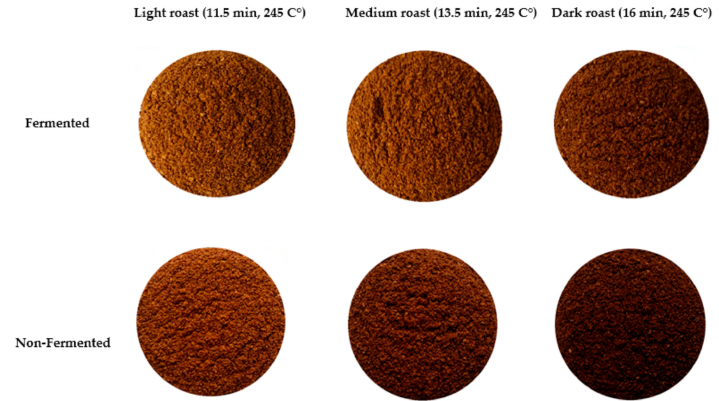
Figure 2. The fermented and non-fermented ground co ff ee that roasted at a di ff erent